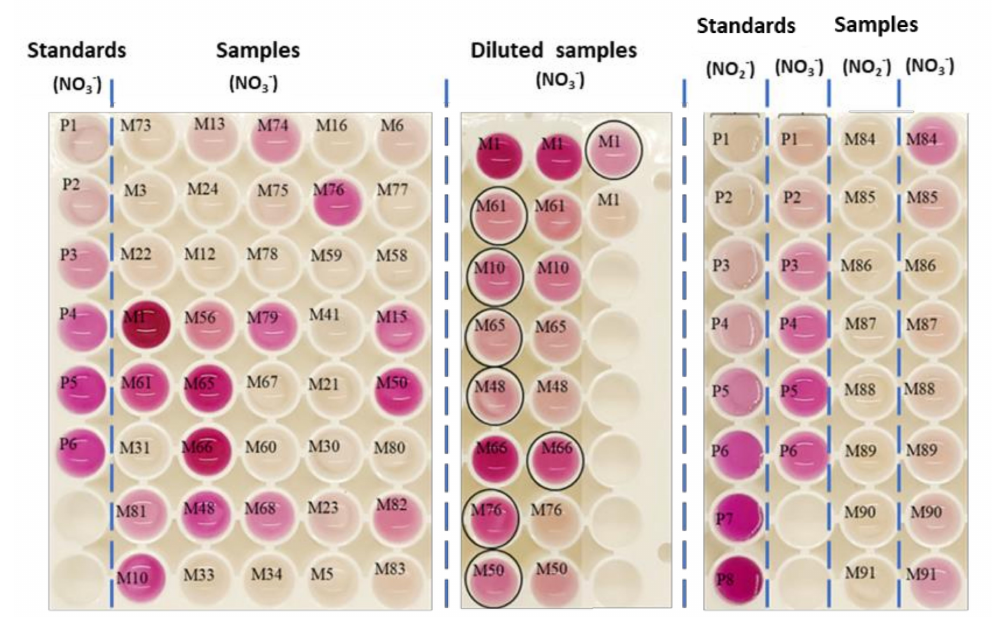
Figure 6. Images corresponding to different concentrations of NO − in 96-microplate of NO − . ( a ) white microplate; ( b ) transparent microplate. 2